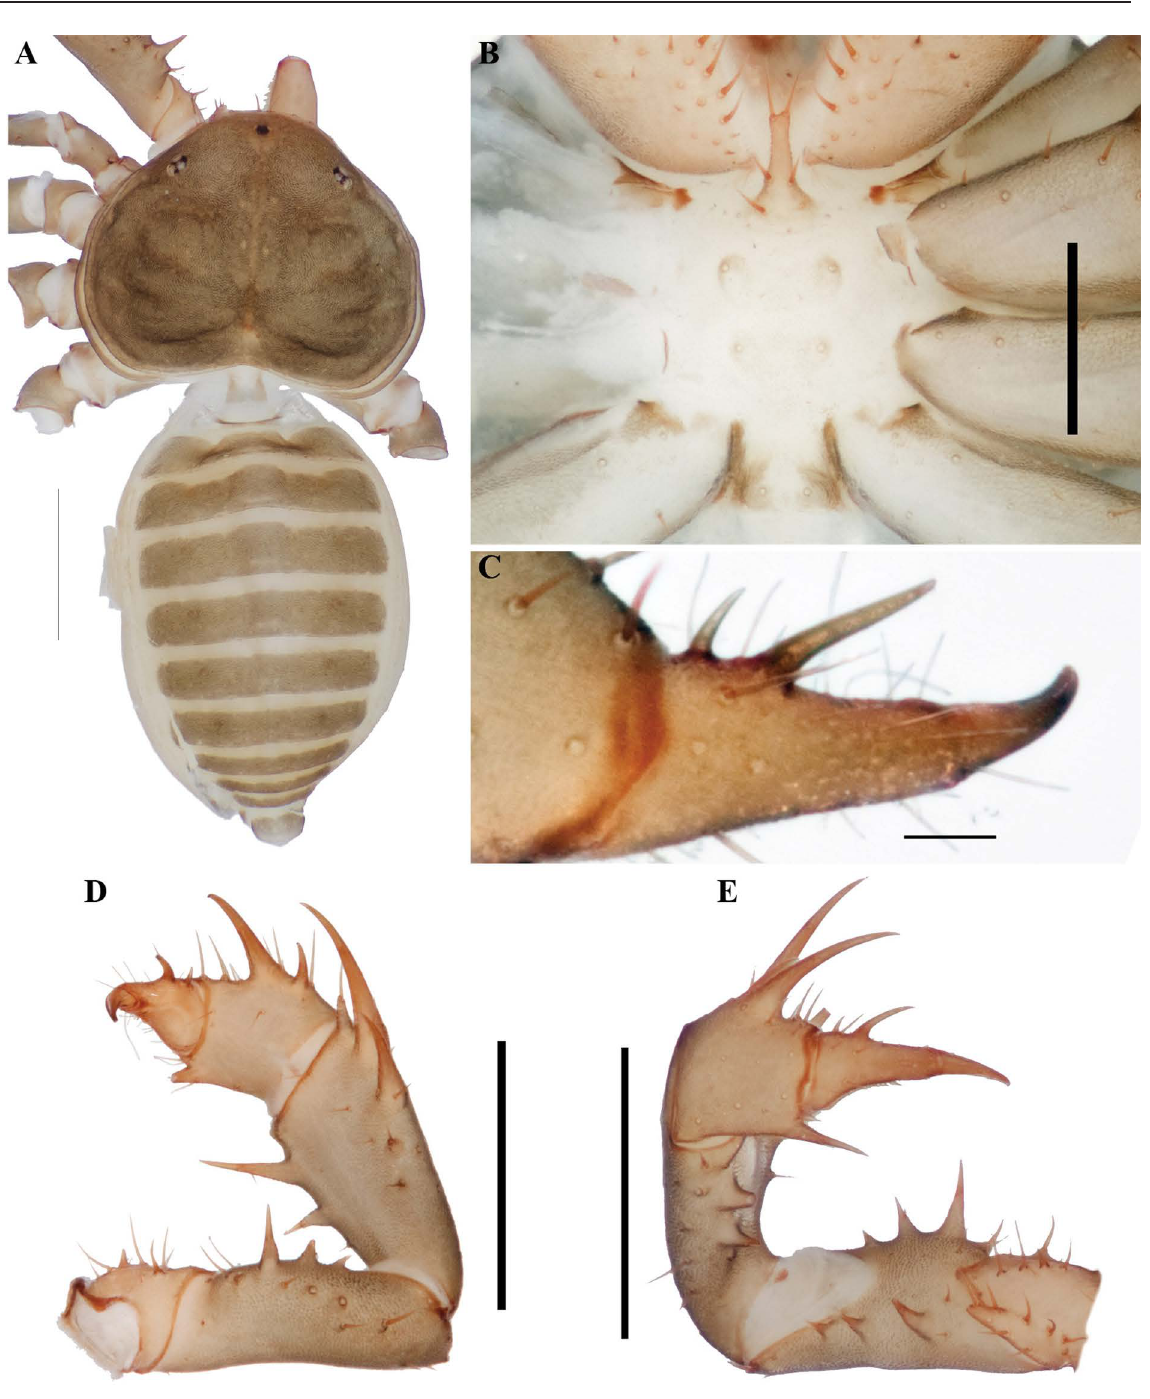
Fig. 13. Charinus aguayoi Moyá-Guzman, 2009 (USNM 782825), general morphology, ♂. A . Carapace, dorsal view. B . Sternum, ventral view. C . Pedipalp tarsus, frontal view. D . Pedipalp, dorsal view. E . Pedipalp, ventral view. Scale bars: A, E–F = 1 mm; B = 0.5 mm; C =